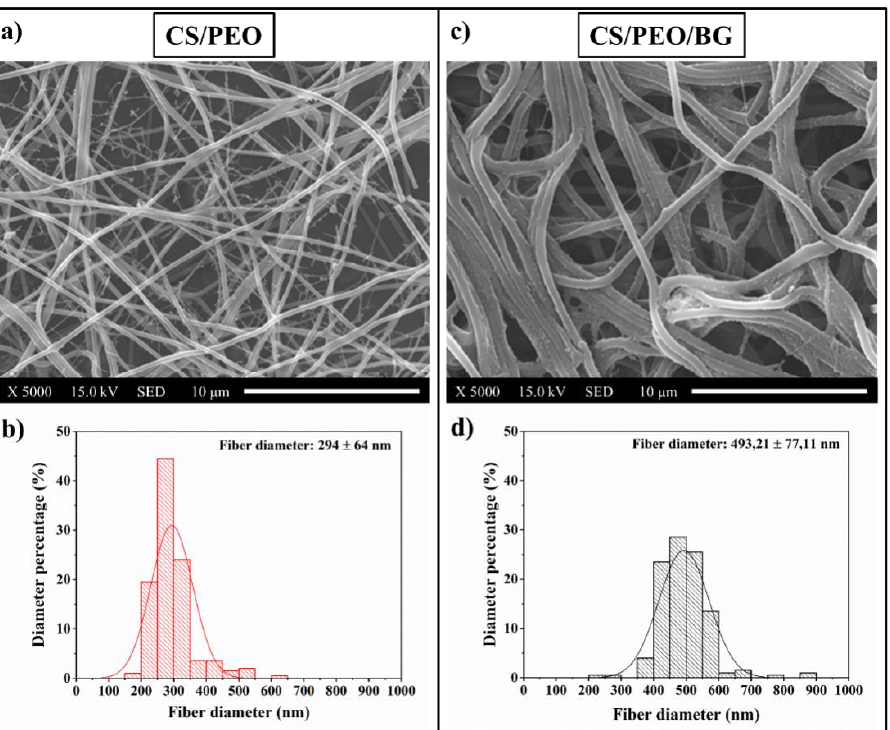
Figure 7. SEM images (collected at 5000X magnification) and diameter distributions of the electrospun nanofiber coatings (CS / PEO ( a , b ) and CS / PEO / BG ( c , d )). The diameter size distributions were obtained analyzing 200 fiber sizes on each surface.